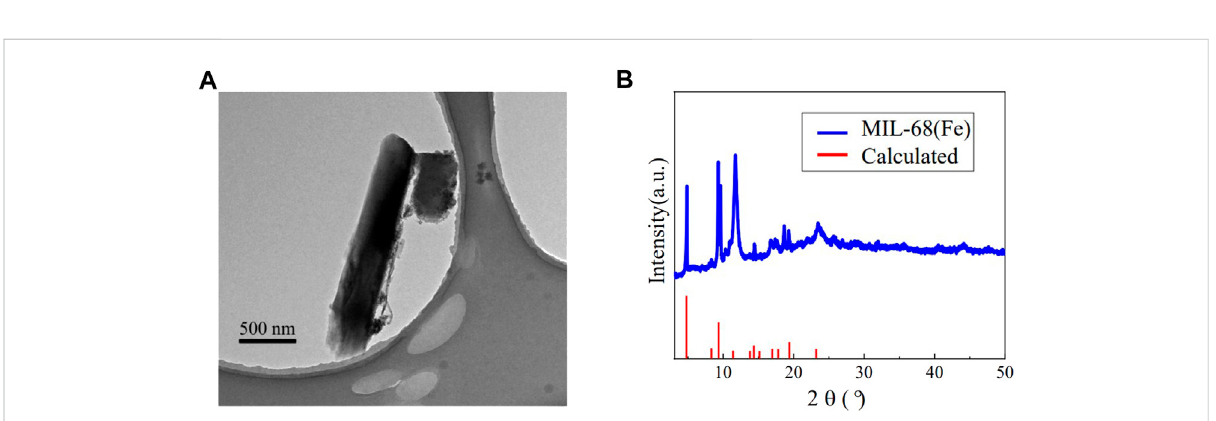
FIGURE 2 (A) TEM image of MIL-68(Fe) with a 500 nm scale; (B) XRD pattern of as-synthesized MIL-68(Fe).